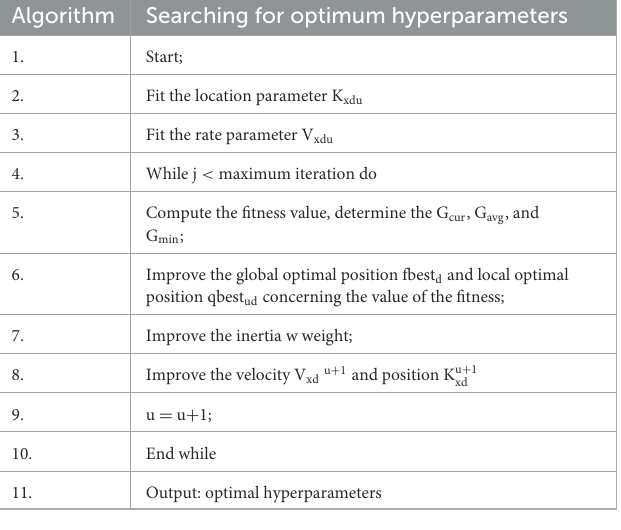
TABLE 3 Searching algorithm for the optimal